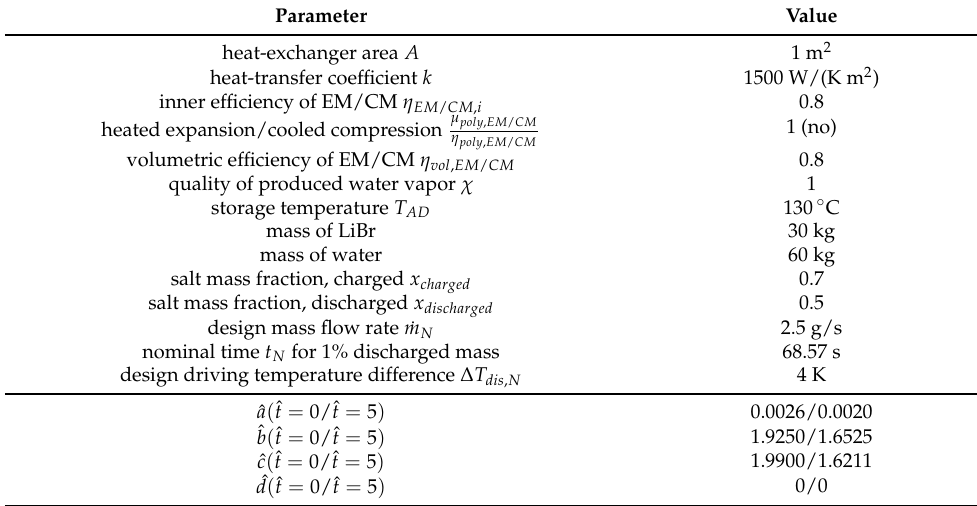
Figure 10. Dimensionless driving temperature difference over dimensionless time for different vapor mass flow rates ˆ˙ m const and different start values ˆ ∆ T dis 0 . Corresponding ˆ ∆ T disR in solid black lines. Table 3. Constant model parameters for the analyzed